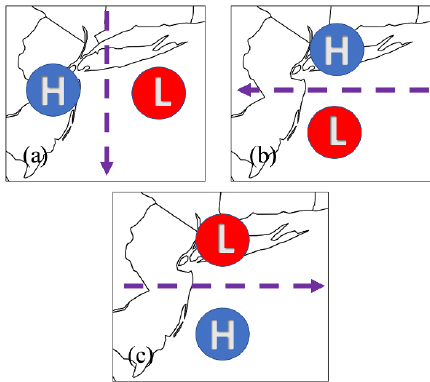
Figure 3. Schematics of the three idealized sea level pressure (SLP) conditions and their associated prevailing wind direction over the targeted region. The blue circle represents high (H) pressure, and the red circle represents low (L) pressure. The purple arrow indicates the direction of the prevailing wind where SLP conditions favor the development of (a) pure sea breeze, (b) backdoor sea breeze and (c) corkscrew sea breeze.